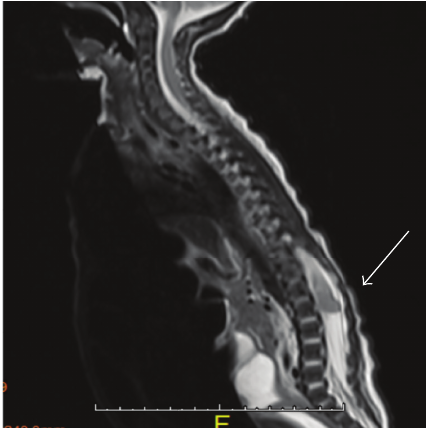
Figure 3: MRI spine, with and without contrast: expansile, some- what lobulated mass in conus medullaris (see arrow).